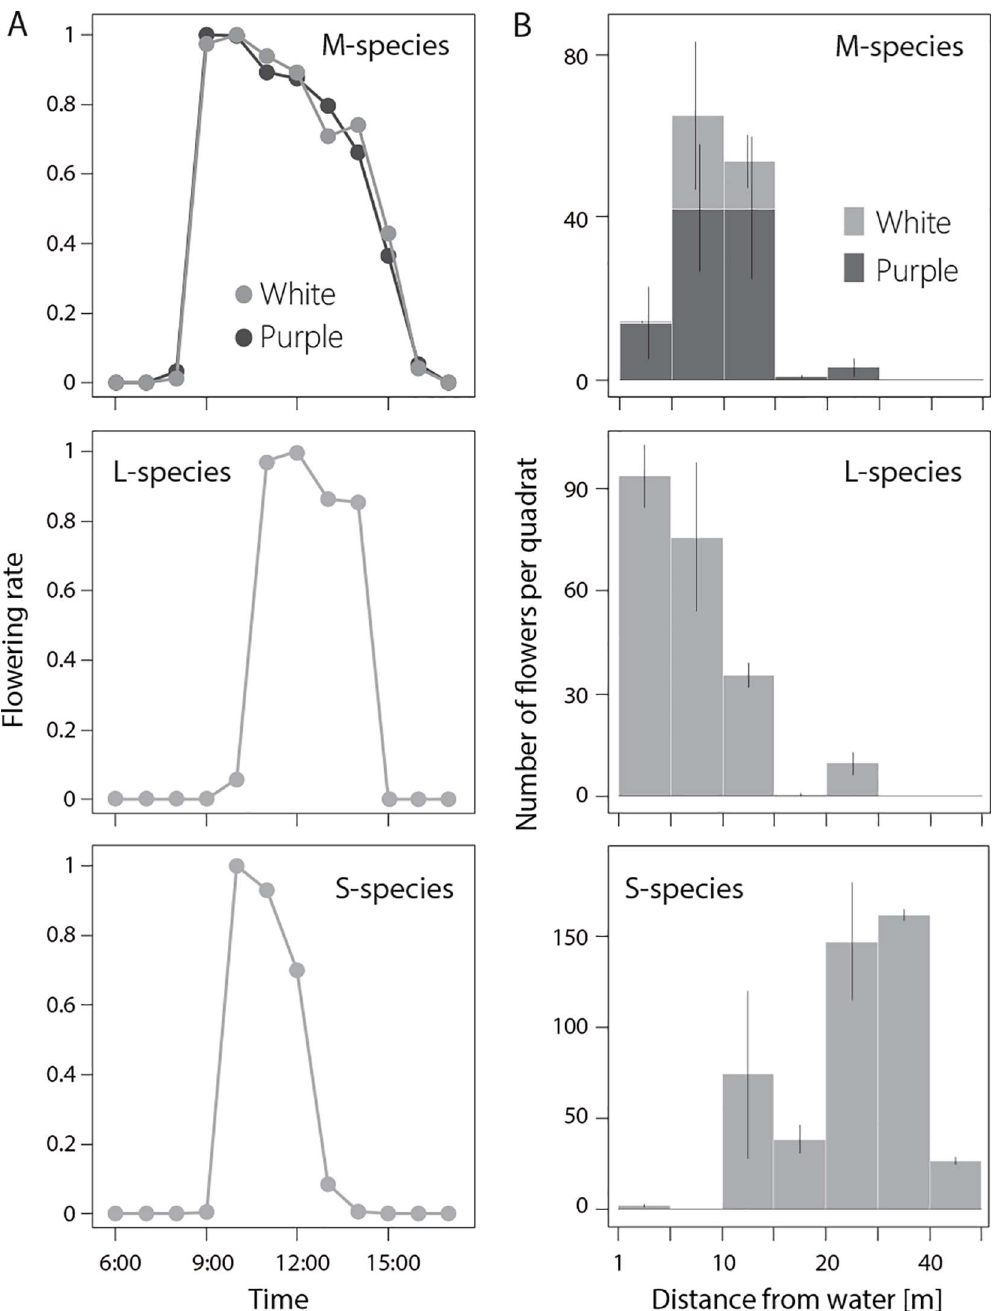
Fig 2. Diurnal blooming rhythm (a) and spatial distribution of the three species (b). Top, middle, and bottom panels represent the results for M-, L-, and S-species, respectively. Error bars are